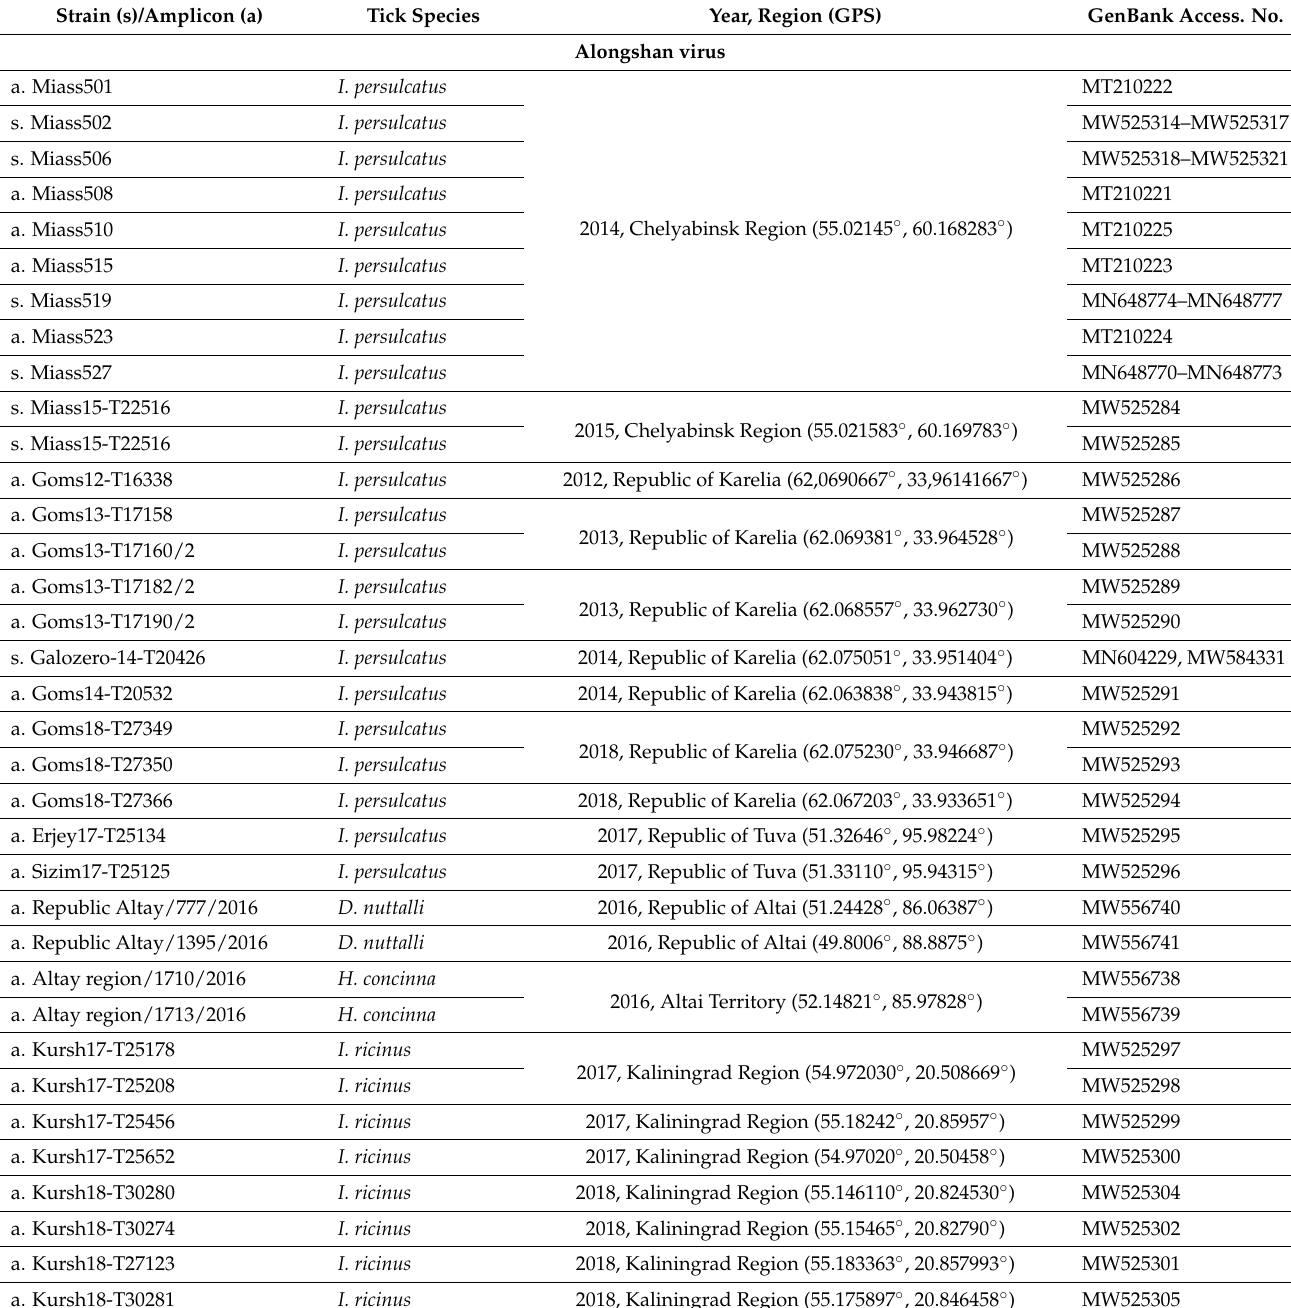
Table 1. Strains (“s”) or amplicons (“a”) of the Alongshan virus and Yanggou tick virus isolated from or detected in Ixodes persulcatus , Ixodes ricinus , Dermacentor nuttalli , Dermacentor reticulatus , Dermacentor marginatus and Haemaphysalis concinna ticks collected in different regions of